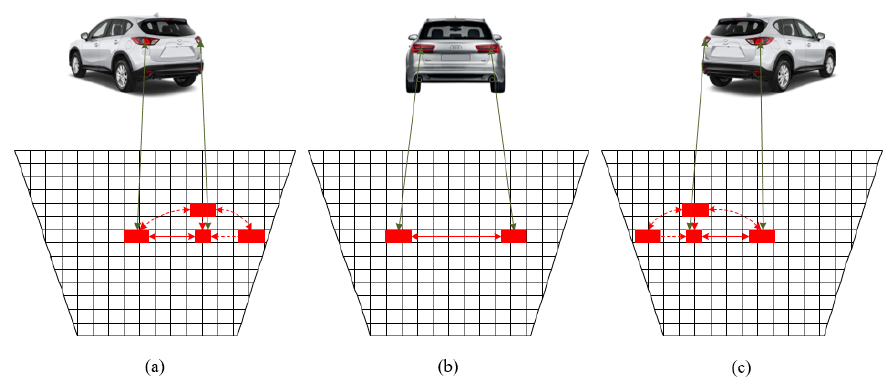
Figure 6. Change of rear LED shapes when the forwarding vehicle ( a ) turns left, ( b ) moves straight, and ( c ) turns right.